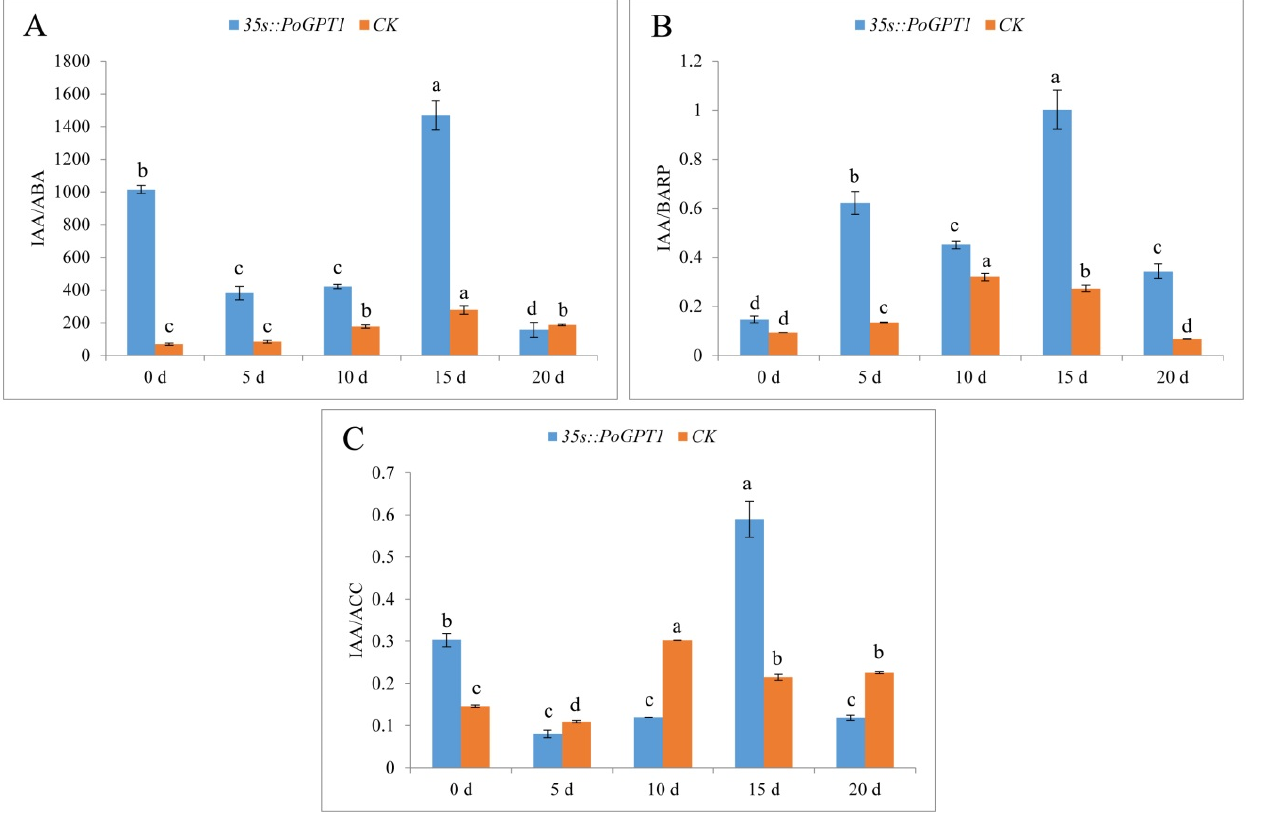
Figure 8. Endogenous plant hormone ratios in tree peony calli (( A ), IAA/ABA; ( B ), IAA/BARP; ( C ), IAA/ACC). Vertical bars indicate standard error ( n = 3). Different letters indicate significant differences using the Duncan’s Multiple Range Test ( p ≤ 0.05).